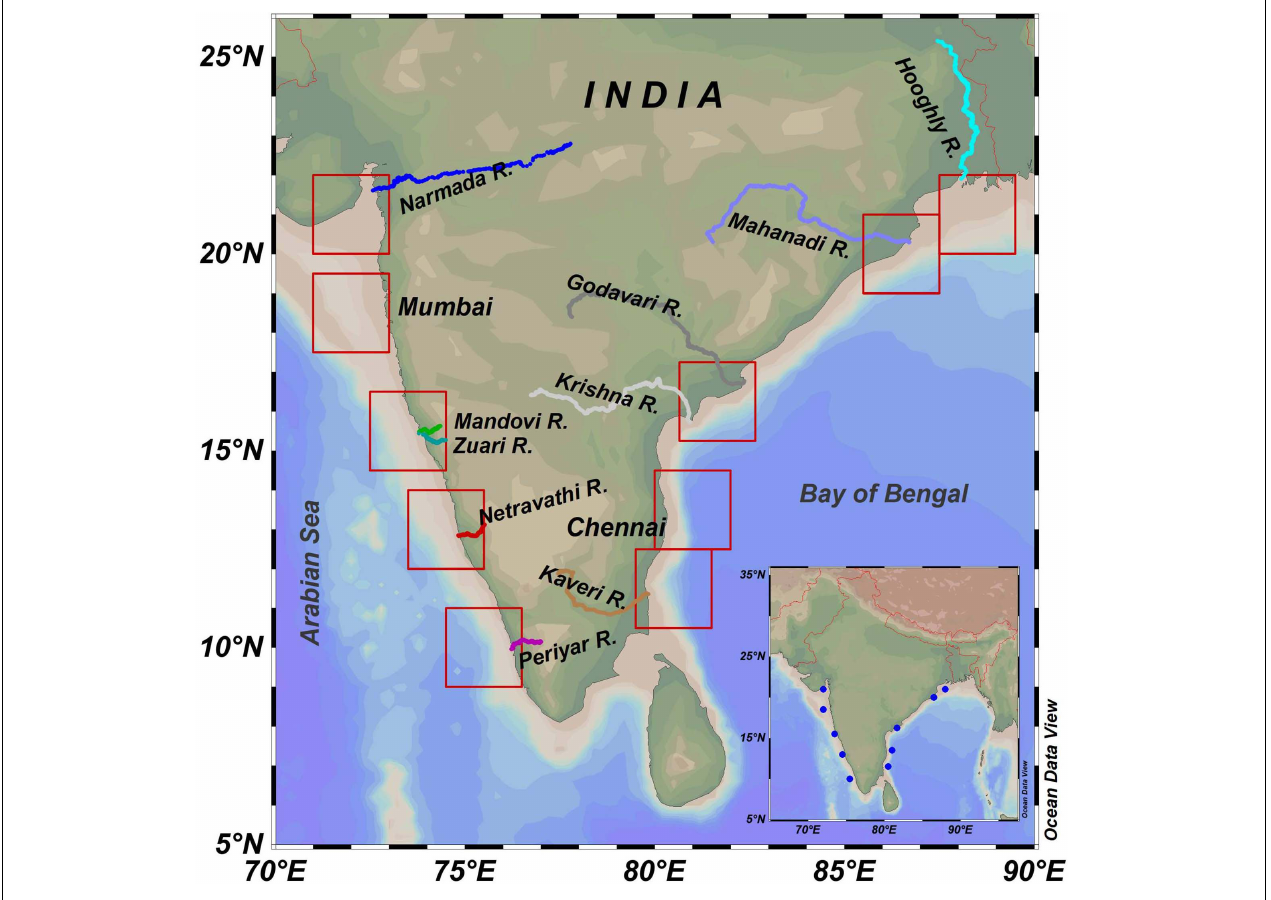
FIGURE 2 | Map showing study regions (2 ◦ × 2 ◦ square boxes) in the Indian coastal waters. The details of geographic domains are provided in Table 1 .